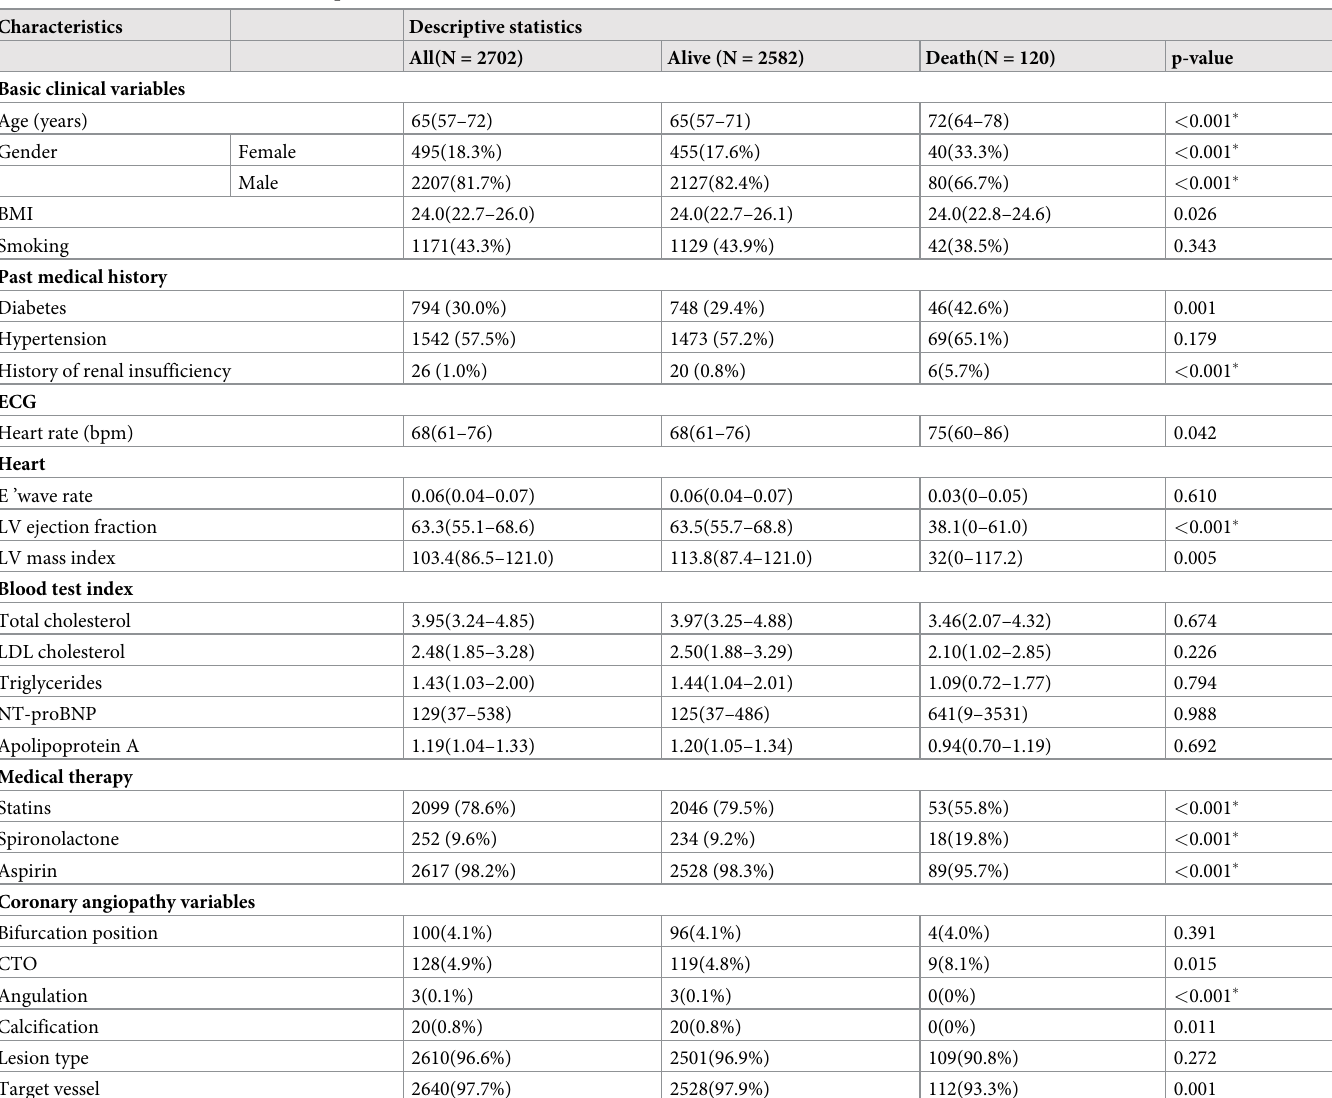
Table 1. Clinical characteristics of the experimental dataset.